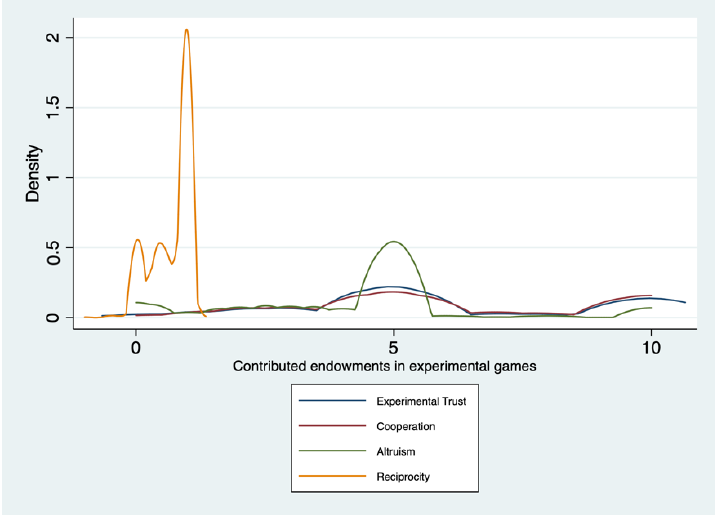
Figure 2. Contributions made in experimental games.